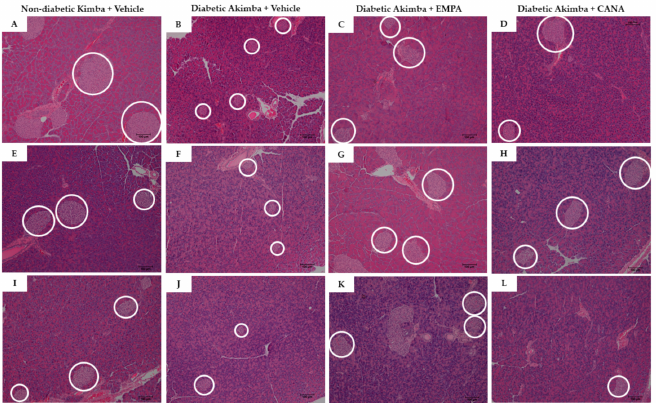
Figure 3. H&E staining of pancreatic tissue from Kimba mice treated with Vehicle ( A , E , I ) and Akimba mice treated with Vehicle ( B , F , J ), EMPA ( C , G , K ), and CANA ( D , H , L ). White circles indicate islets. Scale bar = 100 µ m; Magnification = 100 × . Three representative mice per treatment. H&E: Hematoxylin & eosin; EMPA: Empagliflozin; and CANA: